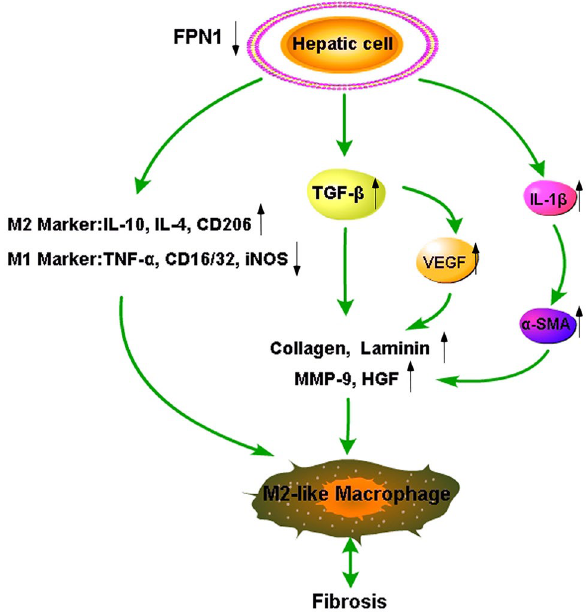
Figure 7. Molecular mechanism of FPN1 involvement in macrophage polarization and hepatic fibrosis. Downregulation of FPN1 in hepatic cells increases the levels of IL-10 and TGF-β , thus inducing macrophage polarization to the M2 phenotype while promoting hepatic